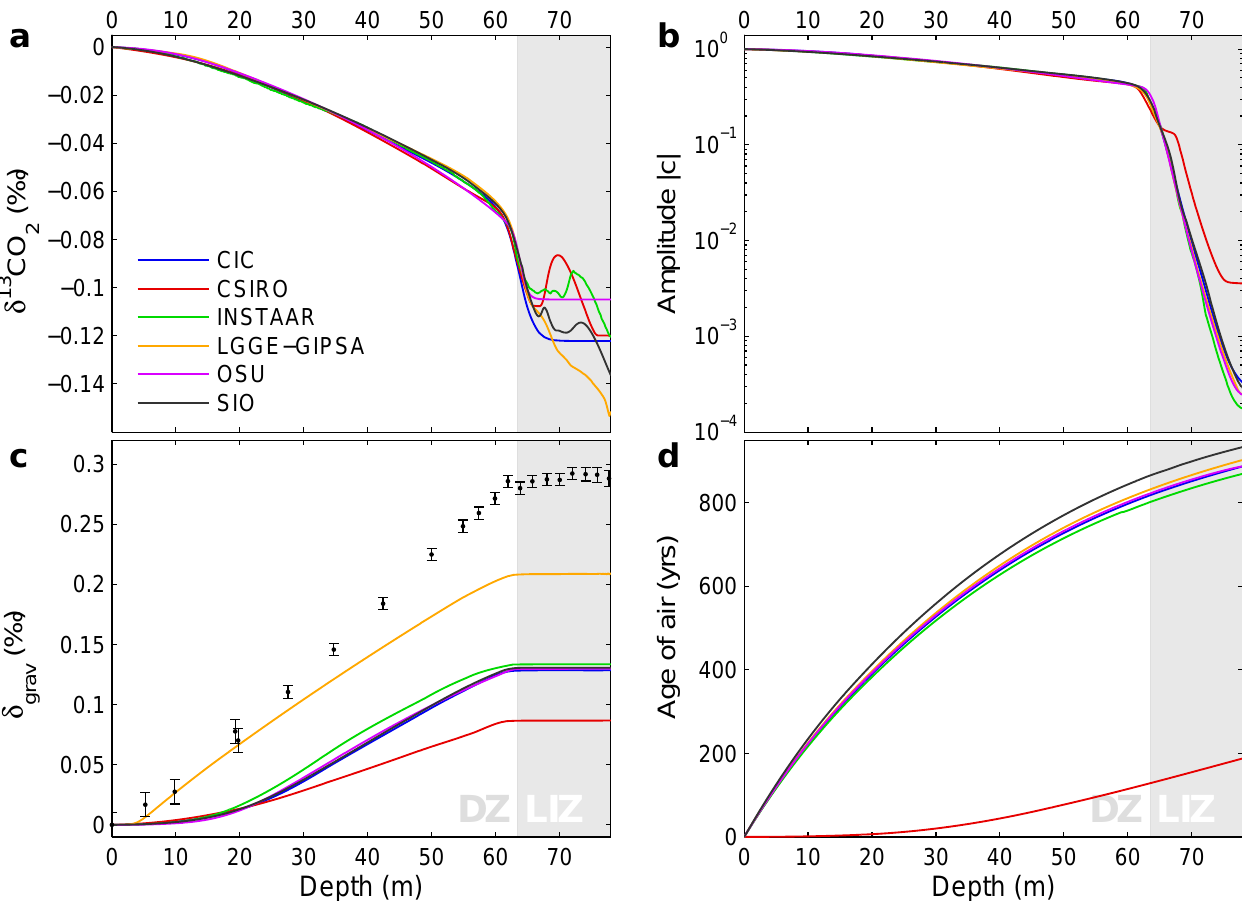
Fig. 9. Model comparison using the four diagnostic scenarios and diffusivity tuned to the EU borehole data. (a) Scenario I: diffusive frac- tionation for a hypothetical monotonic CO 2 increase. (b) Scenario II: attenuation of a 15yr period sinusoidal CO 2 forcing with depth. (c) = 0 . 025 D 0 Scenario III: gravitational enrichment for gas X with D 0 . Data show gravitational enrichment of 15 N 2 corrected for the effect X CO 2 = 0, i.e. of thermal diffusion. See Supplement for details. (d) Scenario IV: mean age of gas Y when using advective transport only ( D 0 Y diffusion is absent). With the exception of S-III all scenarios were run with the effect of gravity turned